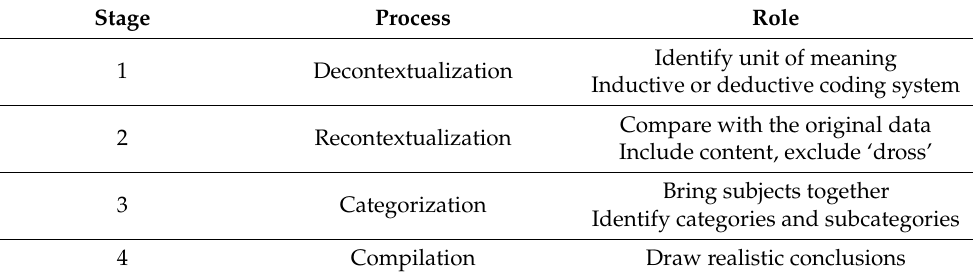
Table 2. Qualitative content analysis process.